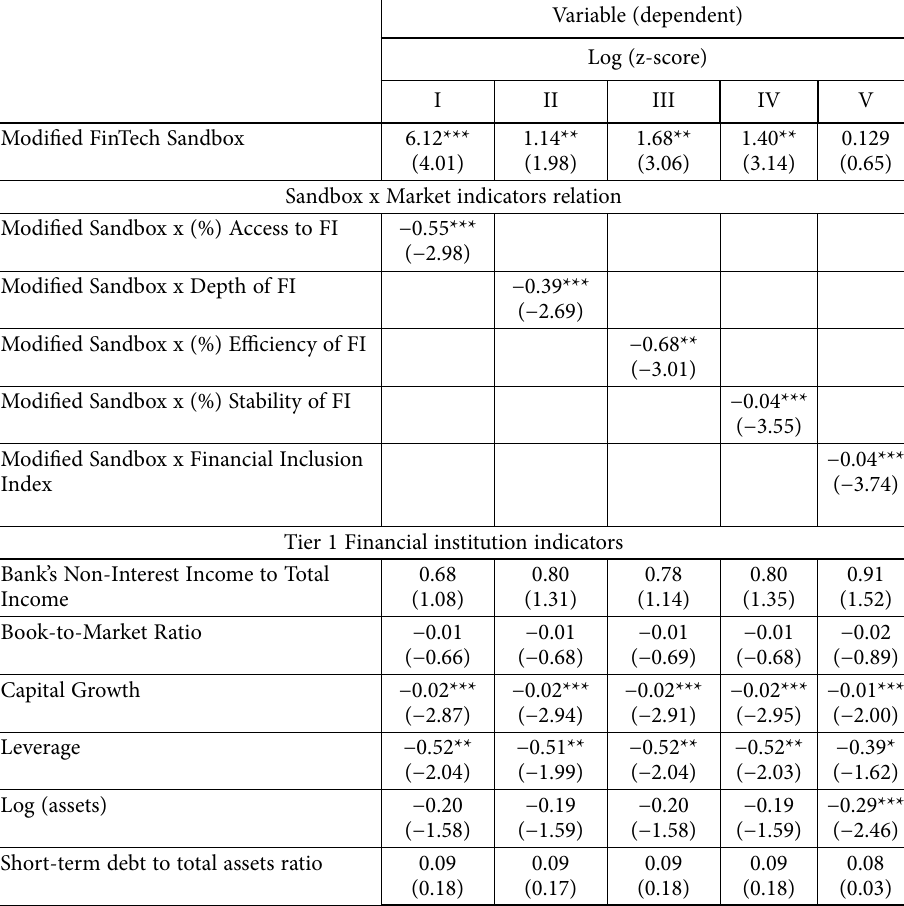
Table 6. Developing FinTech sandboxes (regression of Z-score indicators after reducing for foreign